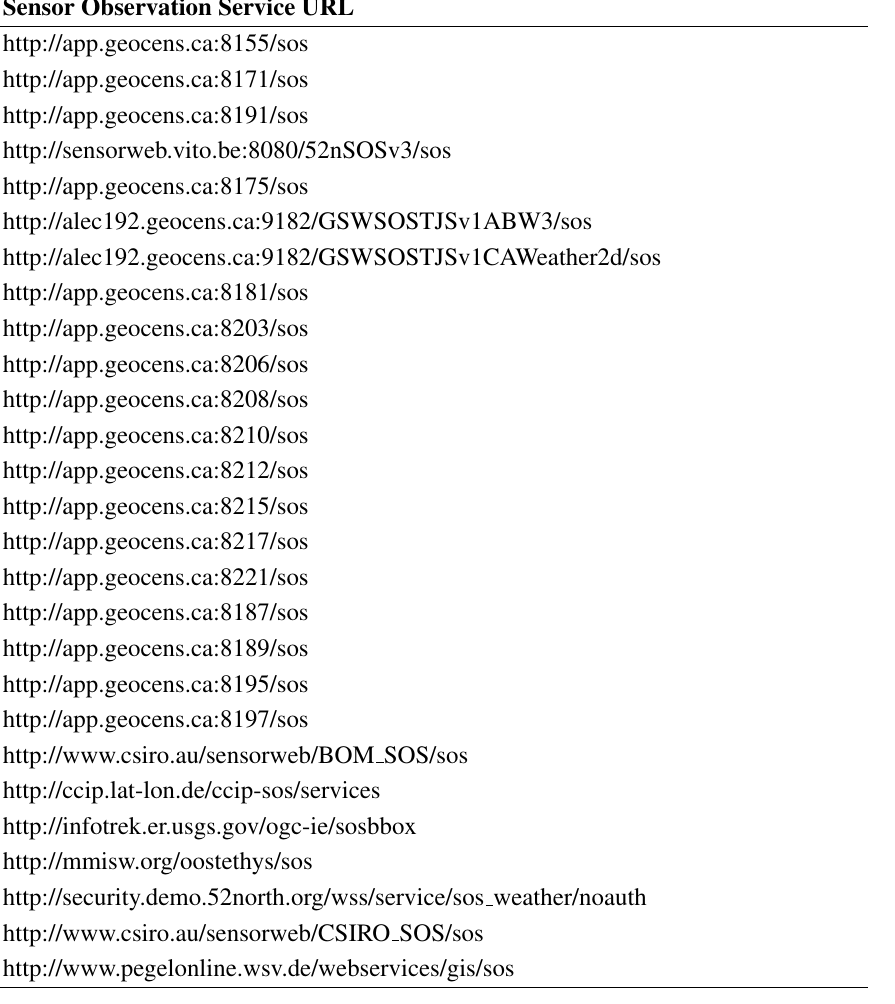
Table 4. List of SOS services used to create property